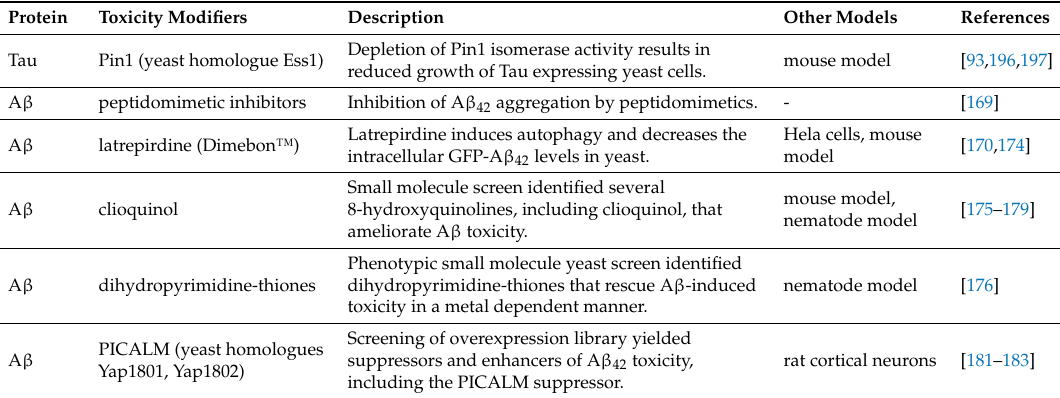
Table 1. Overview of Tau and A β toxicity modifiers identified using yeast-based